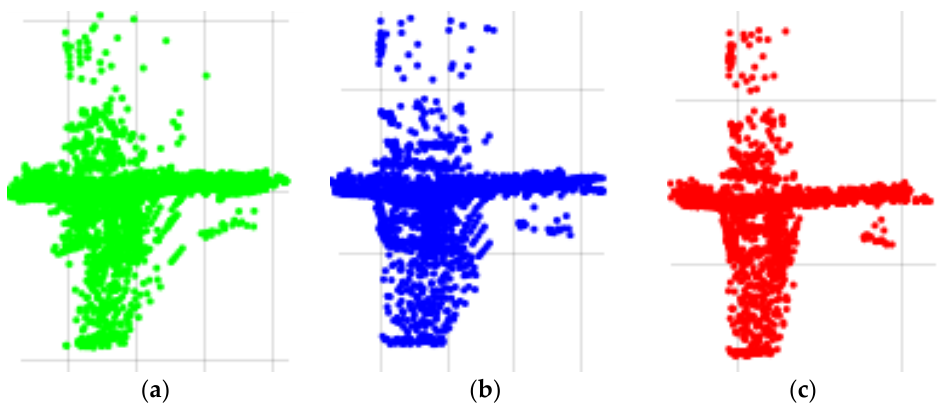
Figure 12. Reconstructions by the three algorithms for Test #1 from data presented in Figure 11: ( a ) center of gravity (COG), ( b ) volume minimization with CA motion model (VM ‐ CA), and ( c ) cube trajectories (CT).